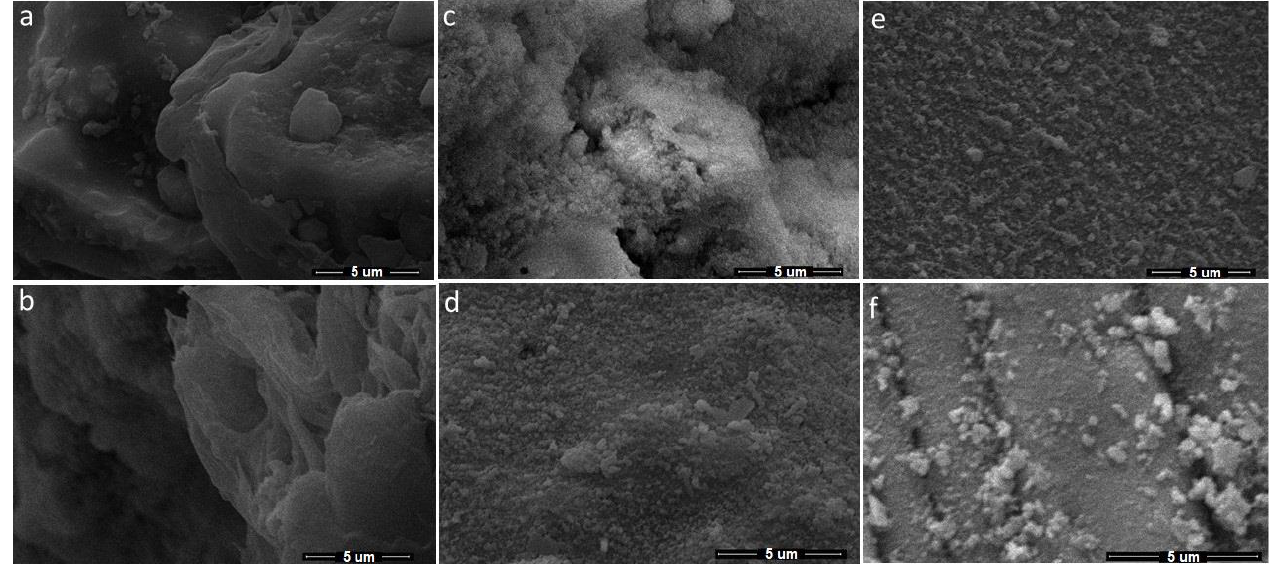
Figure 8. ( a ) Al 2 O 3 wt % 95, SiC wt % 5 at 120 W laser power. ( b ) Al 2 O 3 wt % 95, SiC wt % 5 at 180 W. ( c ) Al 2 O 3 wt % 95, SiC wt % 5 at 150 W. ( d ) Al 2 O 3 wt % 98, SiC wt % 2 at 120 W. ( e ) Al 2 O 3 wt % 98, SiC wt % 2 at 150 W. ( f ) Al 2 O 3 wt % 98, SiC wt % 2 at 180 W.